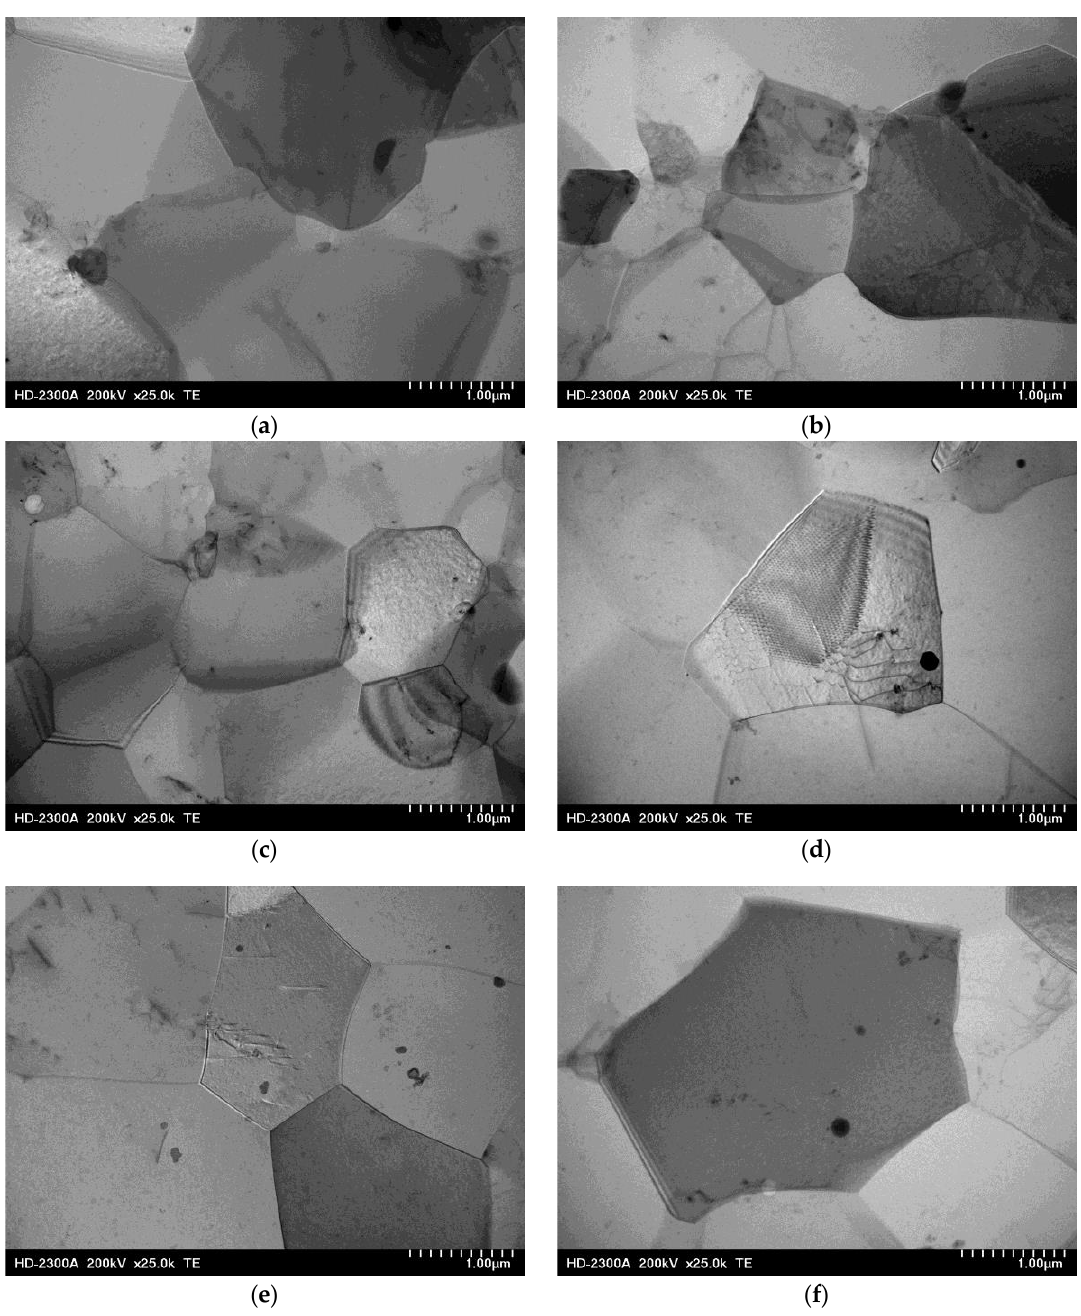
Figure 5. TEM images showing the characteristic microstructures of WE43 alloy after deformation with KoBo method, transmitted electron (TE) images. ( a – c ) Grain/subgrain; ( d ) migration of a wide-angle grain boundary; ( e , f ) recrystallized areas, grains free of dislocations.